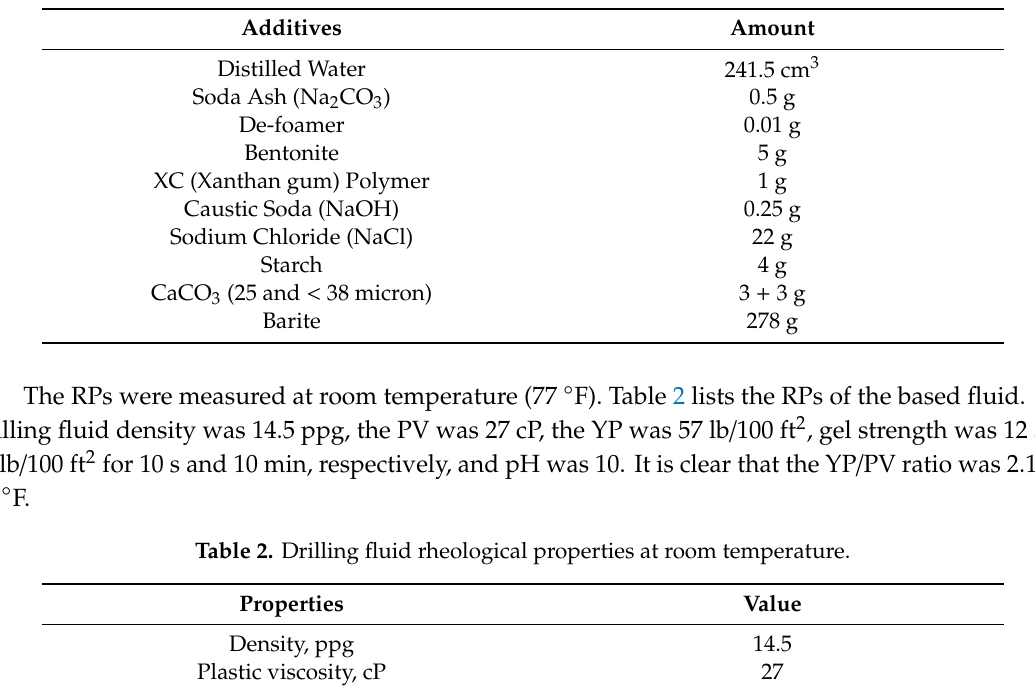
Table 1. Drilling fluid formulation for lab scale.